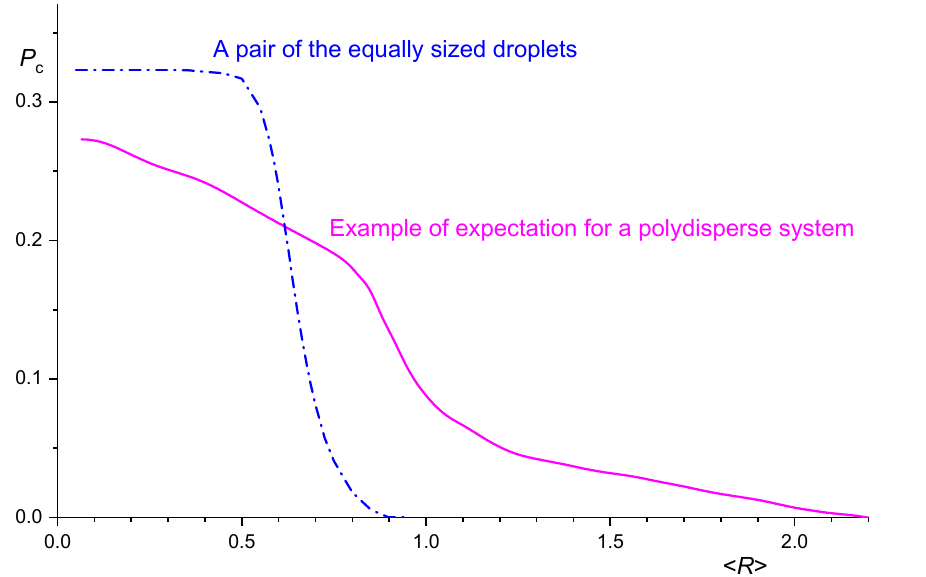
Figure 5. Dependence of collision e ffi ciency ( P c ) on average e ff ective droplet radius for monodisperse (dash-dotted) and polydisperse (solid curve) systems 475